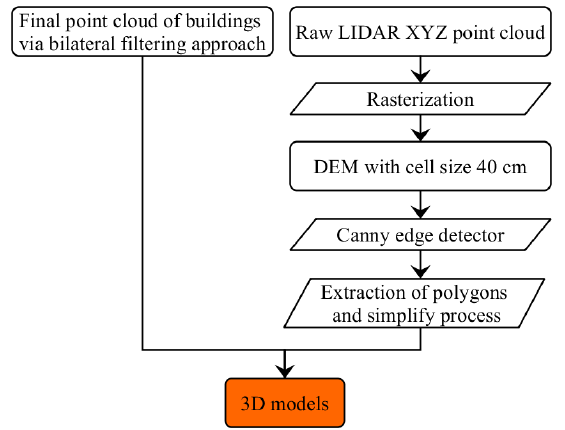
Figure 8. Workflow of the creation of the 3D models in terms of LoD 1.